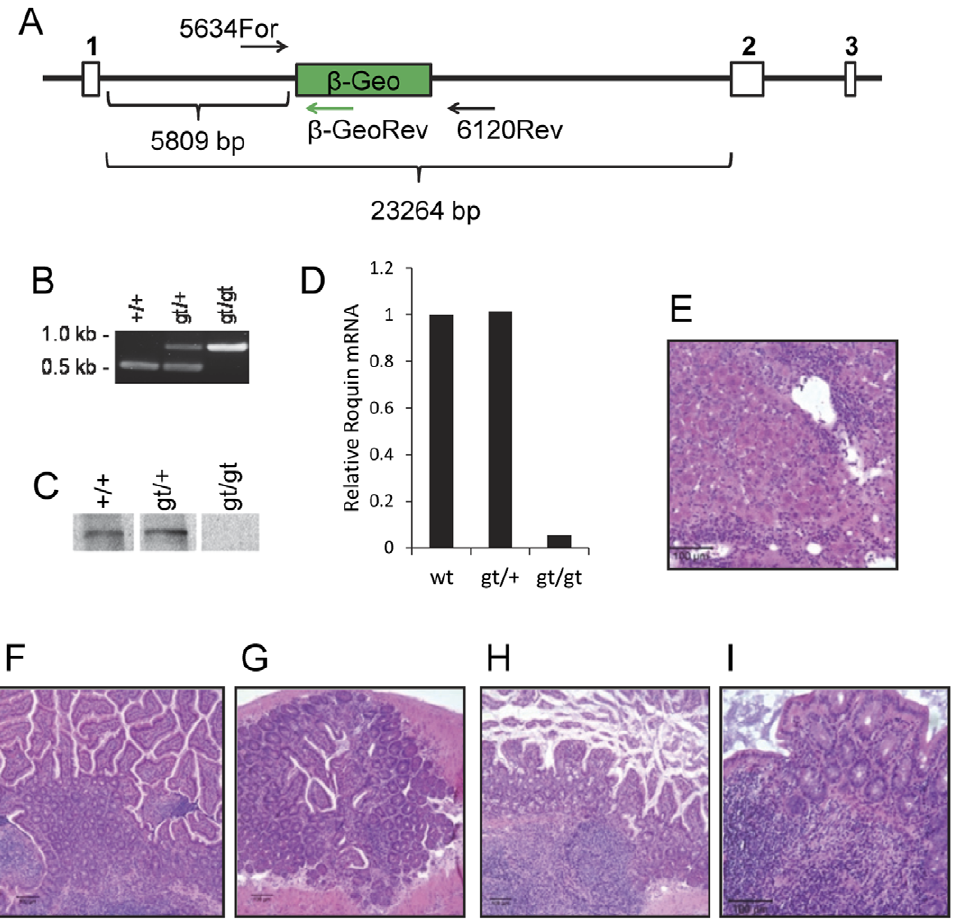
Figure 3. Roquin gt/gt gene trap mice develop extensive small intestine and liver inflammation. ( A ) The location of the b -geo gene trap cassette and genotyping primers relative to the Roquin exons. ( B ) Roquin gt/gt mice were screened using gene trap-specific primers. Mice homozygous for the gene trap had a single band of 800 bp; heterozygotes had two bands of 800 bp and 486 bp; wild type mice had a single 486 bp band. Animal ages 16–22 weeks. ( C ) The Roquin protein was undetectable in the spleen of homozygous (gt/gt) mice by western blotting; 1animal each. Animal ages 16–22 weeks. ( D ) Roquin gene expression in the intestine of homozygous (gt/gt) mice was reduced by , 95%; 1animal each. Animal ages 16– 22 weeks. Representative H&E stained tissue sections of the ( E ) liver, ( F ) duodenum, ( G ) jejunum, ( H ) ileum, and ( I ) cecum of a Roquin gt/gt mouse exhibited chronic hepatitis and intestinal inflammation. Pathology scores of sections are described in the text. E–I, original magnifications, 200 6 .